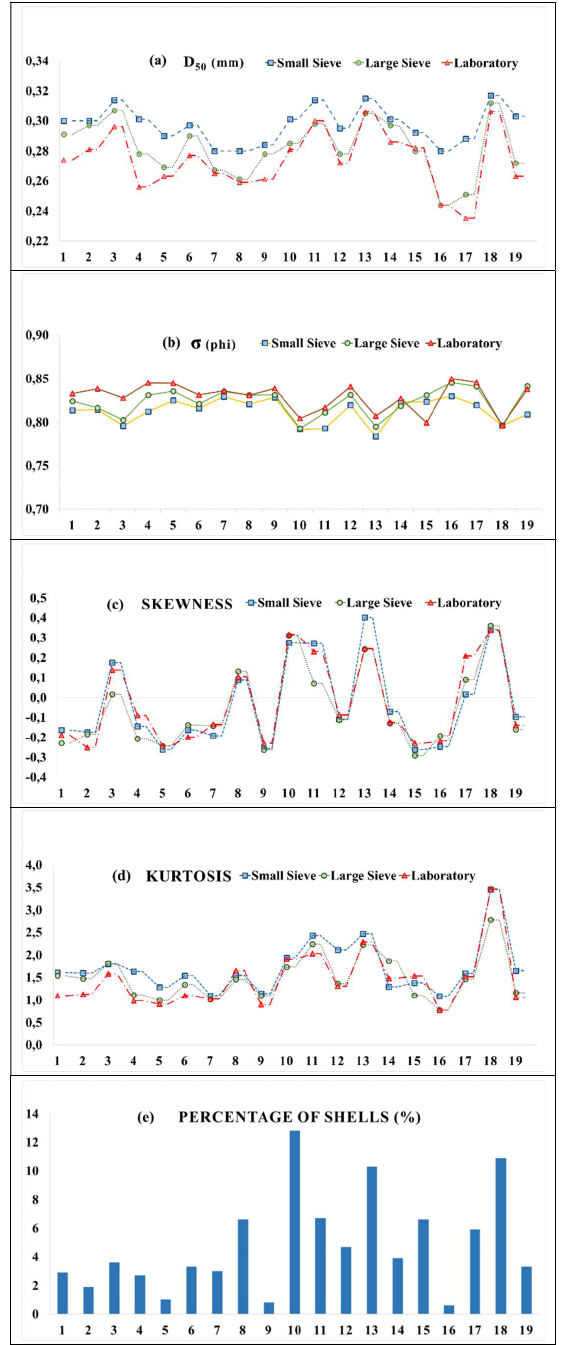
Figure 3. Values of the granulometric parameters obtained with three different types of sieving for the samples taken on board of the dredger: ( a ) D 50 ; ( b ) sorting; ( c ) skewness; ( d ) kurtosis; ( e ) percentage of shells.